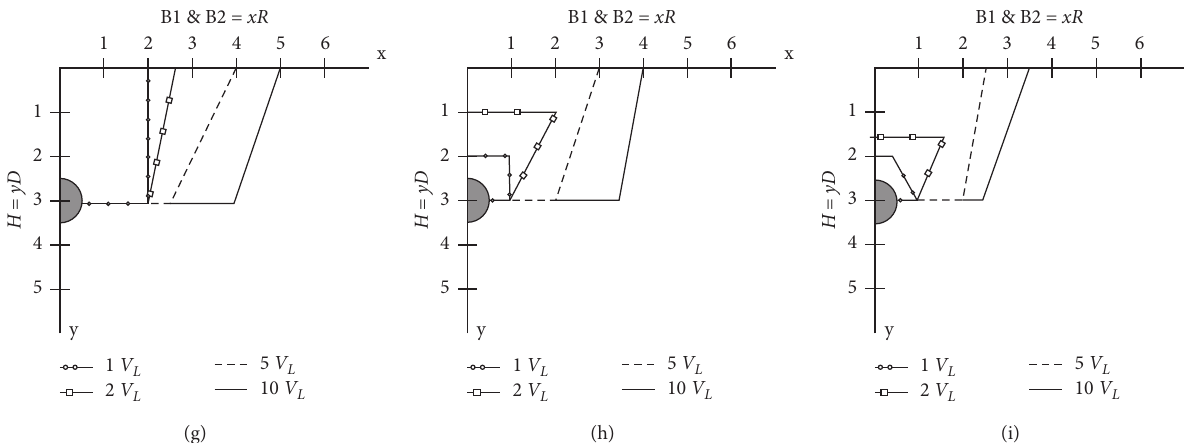
Figure 8: Influence zones for tunnel size, D � 6m. 8 (a)–(c) Tunnel placed at depth of tunnel size “ D ” for various volume loss percentage “ V L .” 8 (d)–(f) Tunnel placed at twice the depth of tunnel size “ D .” 8 (g)–(i) tunnel placed at thrice the depth of tunnel size “ D .” (a) D � 6m and z � 1 D in LS. (b) D � 6 m and z � 1 D in MDS. (c) D � 6m and z � 1 D in DS. (d) D � 6m and z � 2 D in LS. (e) D � 6 m and z � 2 D in MDS. (f) D � 6m and z � 2 D in DS. (g) D � 6m and z � 3 D in LS. (h) D � 6m and z � 3 D in MDS. (i) D � 6m and z � 3 D in